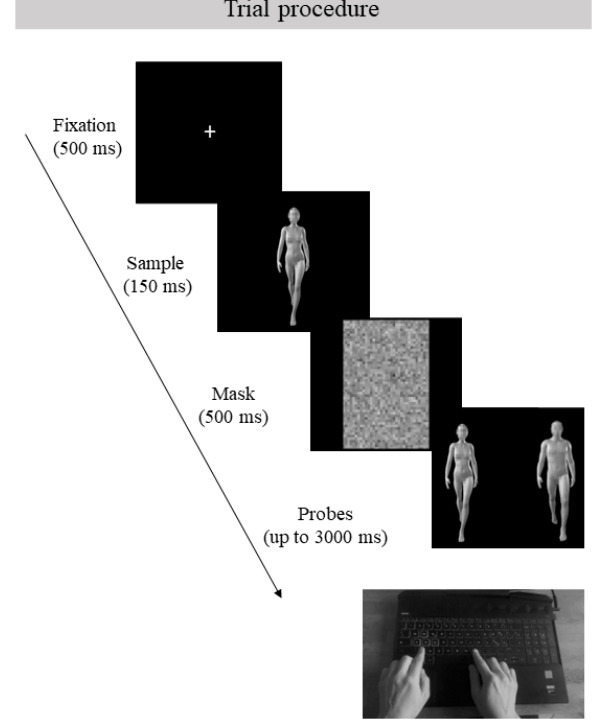
Figure 2. Trial procedure. A representation of the events constituting the structure of a single trial of the matching-to-sample task. Each trial began with the fixation cross, followed by the target picture. Soon after the mask appeared, a frame with the two probes remained on the screen until a response was recorded or for a maximum of 3000 ms. The background color of the screen remained black for the whole duration of the experiment.